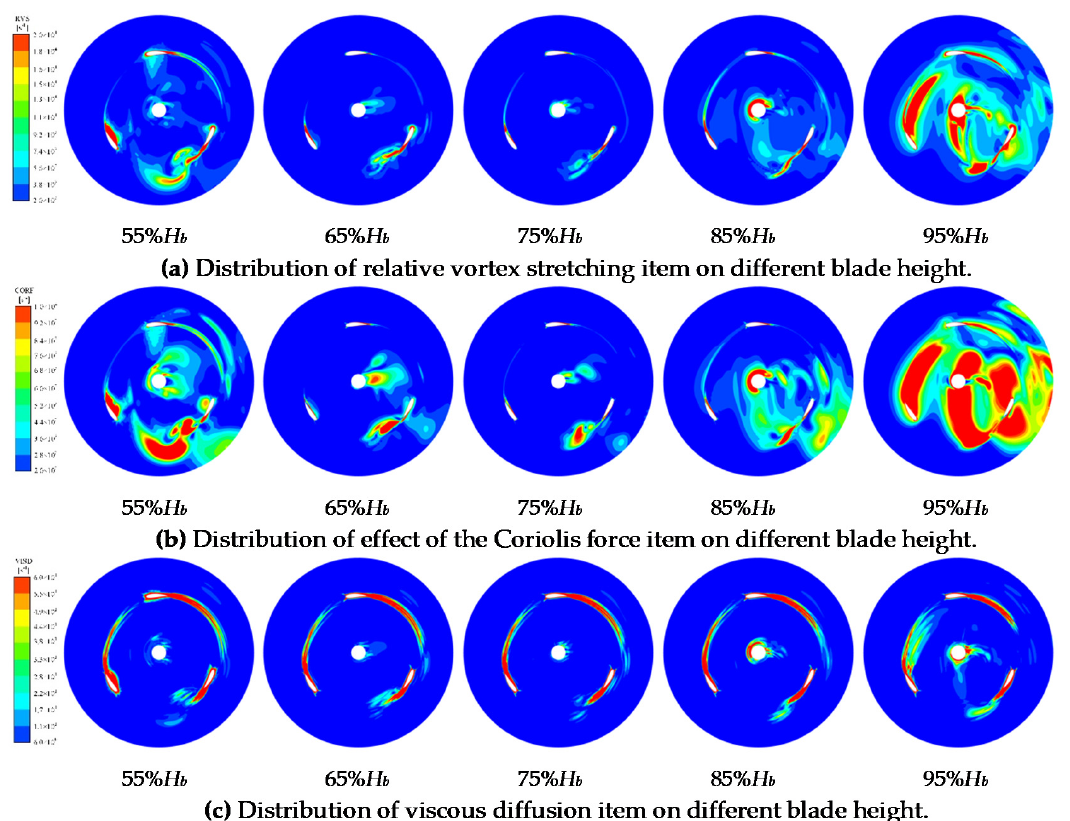
Figure 14. Distribution of the relative vortex stretching item, effect of the Coriolis force item, and viscous diffusion item on different blade height at λ = 2.0. ( a ) Relative vortex stretching item; ( b ) Coriolis force item; ( c ) Viscous diffusion item.